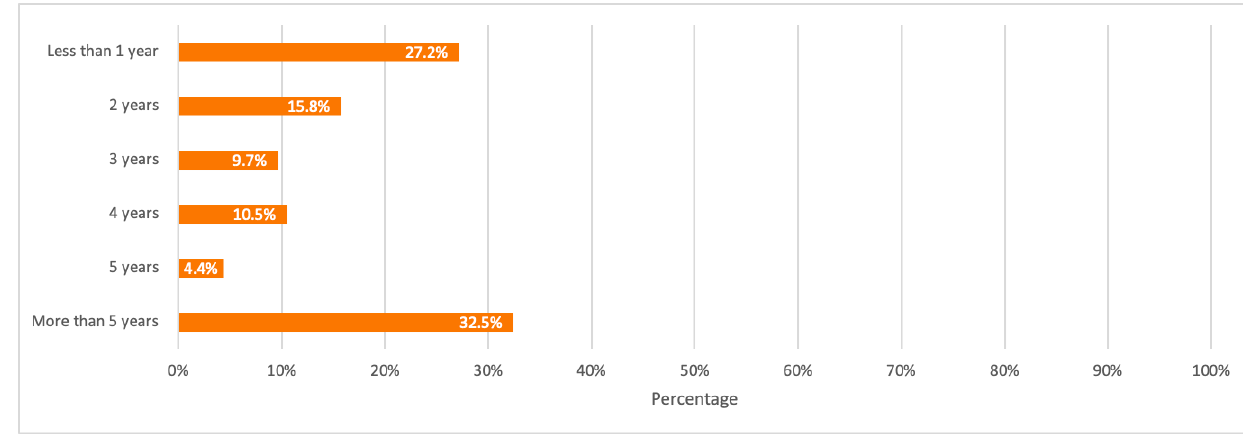
Figure 15. Respondents’ old mobile phones storage duration.